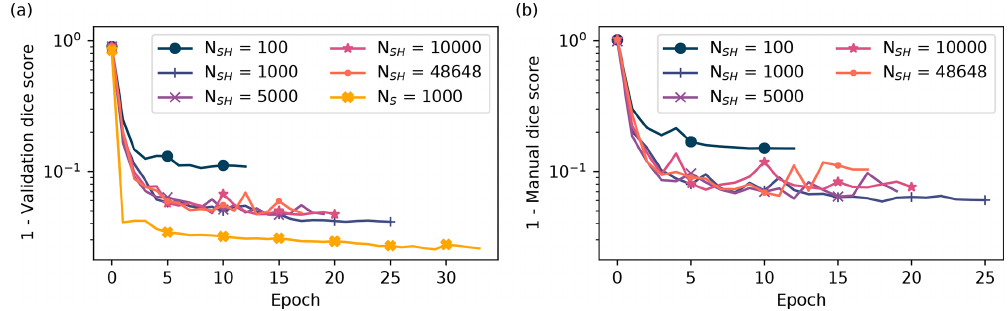
Figure A1. The average dice coefficient versus epochs computed on the validation set of training tiles and masks in (a) , and on the validation set of human-evaluated HOLODEC images and binary labels in (b) . Models trained and optimized with both the synthetic and the HOLODEC images are shown in (b) .